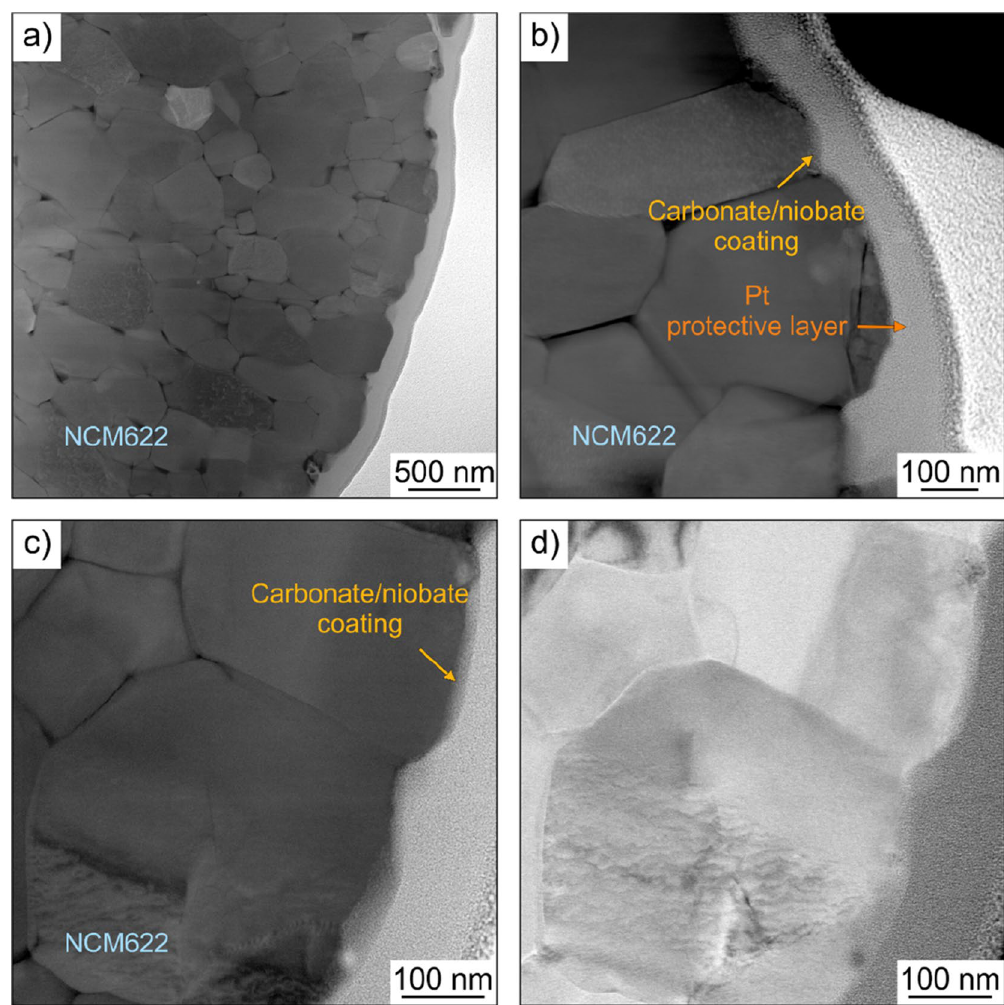
Figure 1. ( a – c ) High-angle annular dark-field and ( d ) bright-field STEM images of the coated NCM622 cathode material (sample